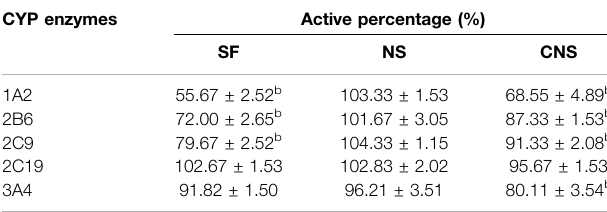
TABLE 2 | Percentage of activity of fi ve CYP450 subtypes in hiHeps groups. CYP